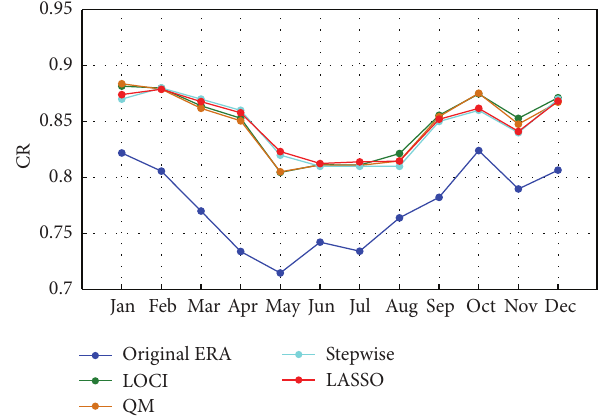
Figure 3: Averaged correspondence ratio (CR) for each month in the validation period